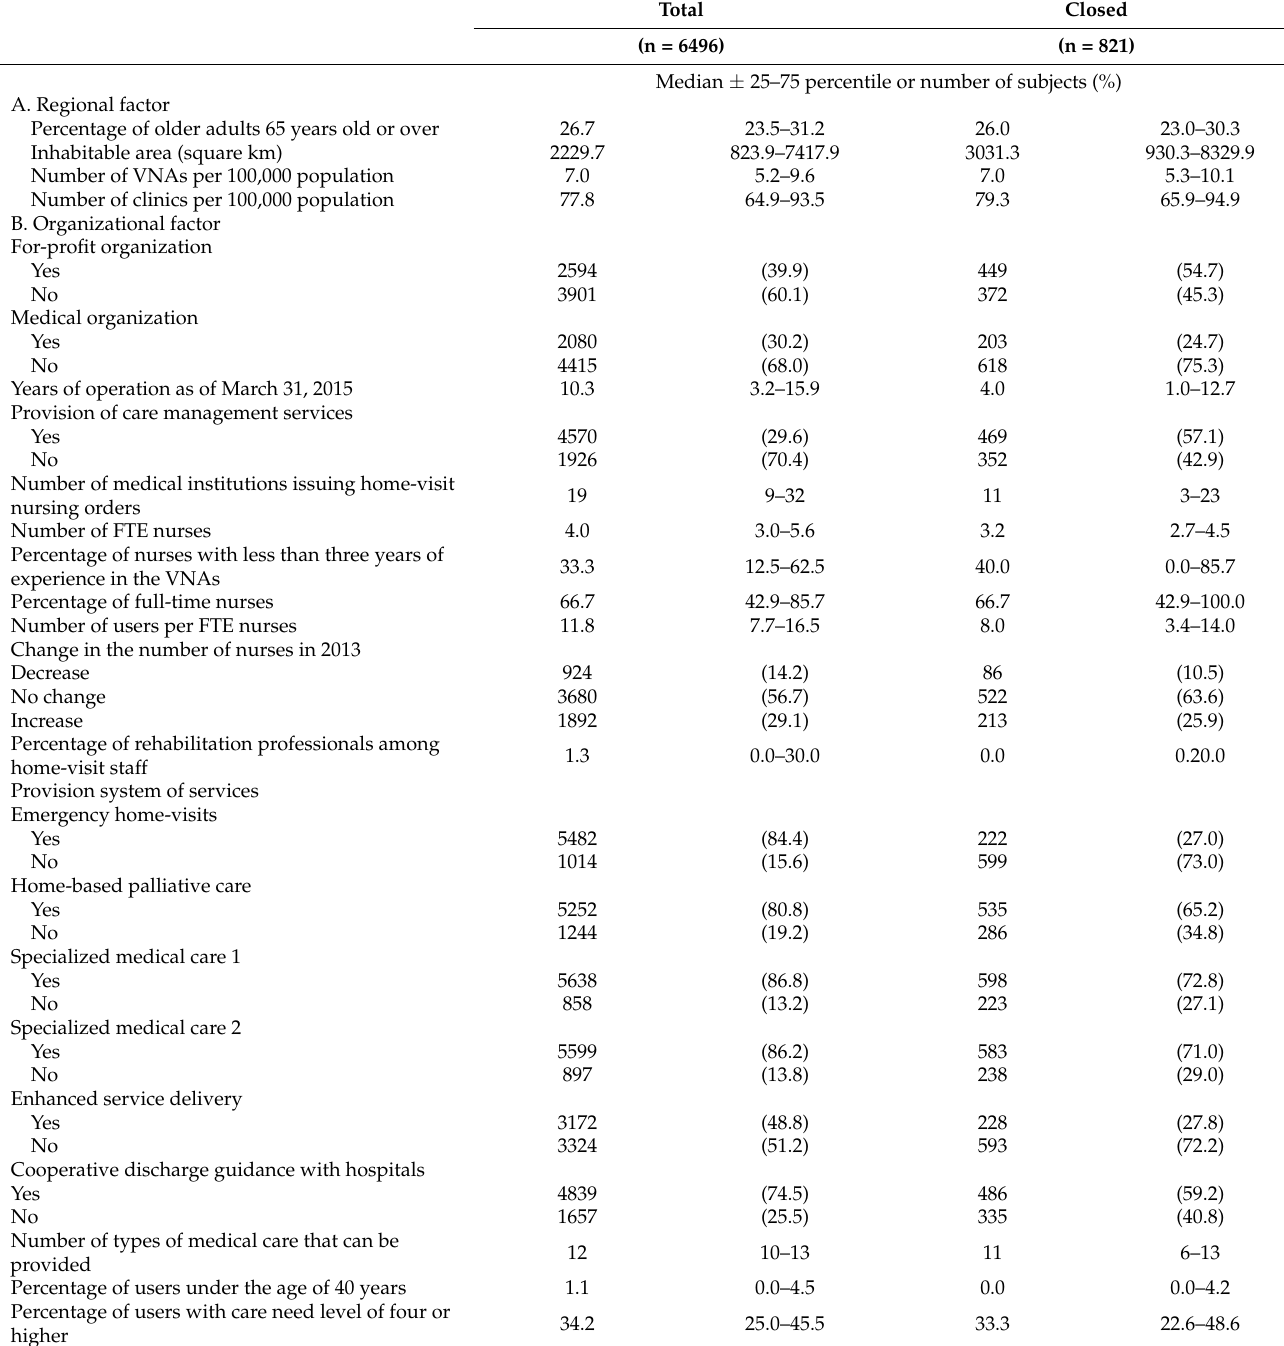
Table 1. The basic characteristics of the study population, total, and closed home-visit nursing agencies. Total Closed (n = 6496) (n = 821) Median ± 25–75 percentile or number of subjects (%) A. Regional